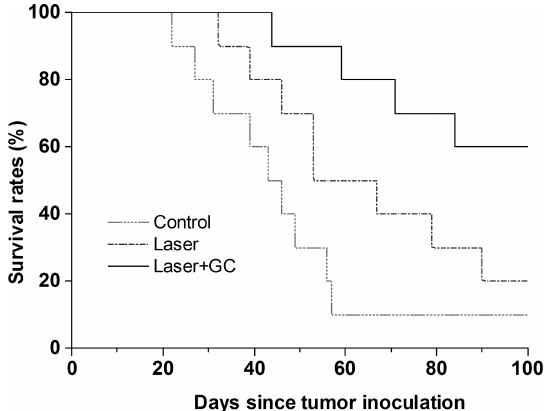
Fig. 2. Anti-tumor immune e®ect of laser þ GC treatment. Animal survival mice in the adoptive immunity experiments using splenocytes from treated mice as immune cells. Viable tumor cells were admixed with splenocytes from di®erent mice, then injected into naive mice. The splenocytes to tumor cell ratio was 50,000,000:100,000 per mouse. The splenocytes from mice treated by laser þ GC protected 60% of the recipients and splenocytes from mice treated by laser only protected 20% of the